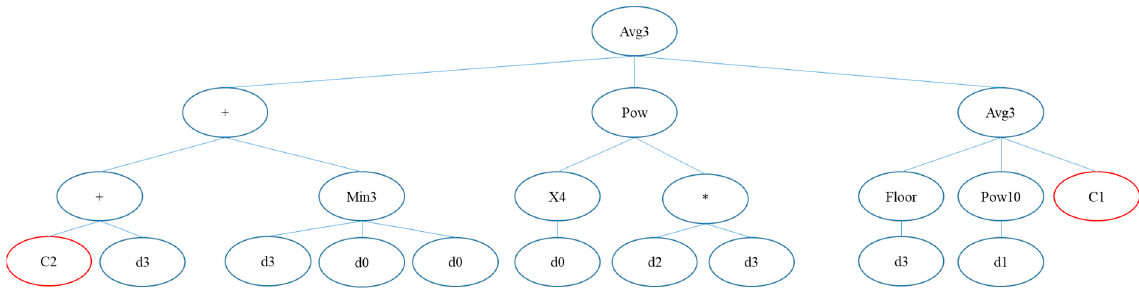
Figure A1. Sub-ET1 of GEP bathymetry retrieval model.